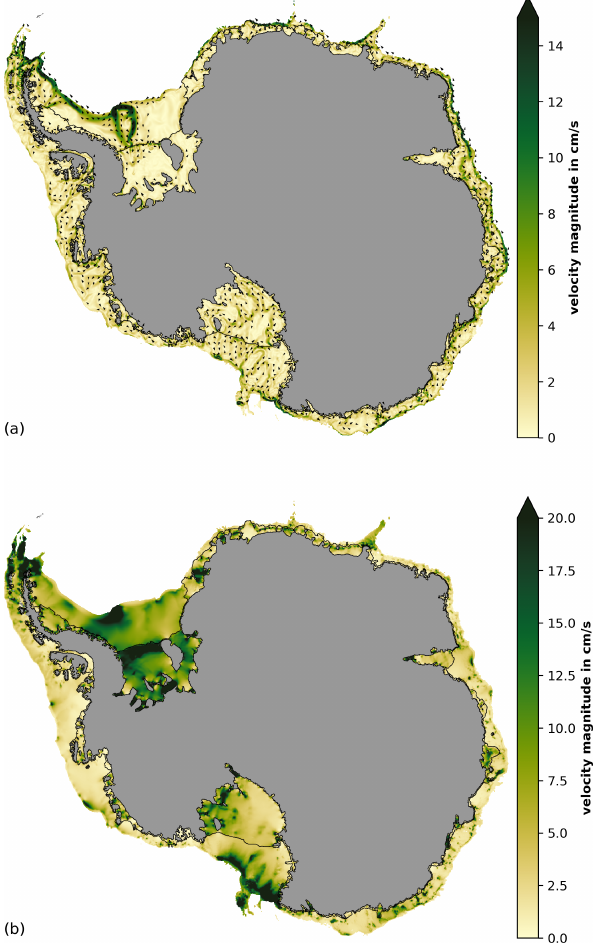
Figure 4. Tide-induced change in (a) magnitude and direction of the depth-averaged velocity vector and (b) depth-averaged potential temperature. Differences show the impact when activating tides in the model (Tides − No-Tides). Arrows in (a) are shown only where velocity change is larger than 1cms − 1 . Panel (a) is very similar to residual flow due to tide–topography interaction alone (see Fig.